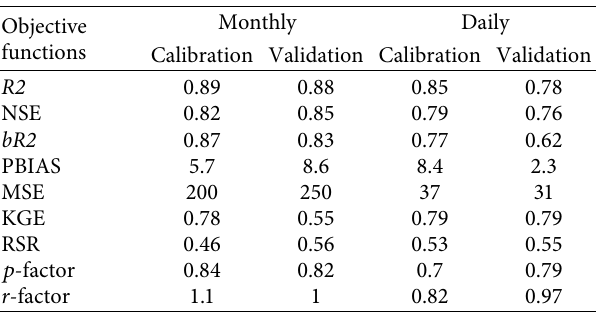
Table 8: Model evaluation performance of the streamflow cali- bration and validation results on monthly